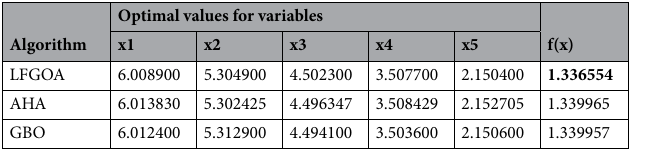
Table 17. Results of the comparative algorithms for solving the cantilever beam design problem. The best of the comparison results are in [bold].